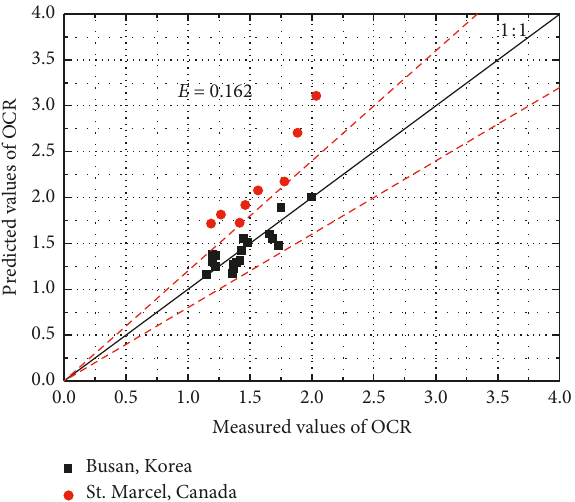
Figure 10: Comparison of the measured values and predicted values of the OCR using Method 1.